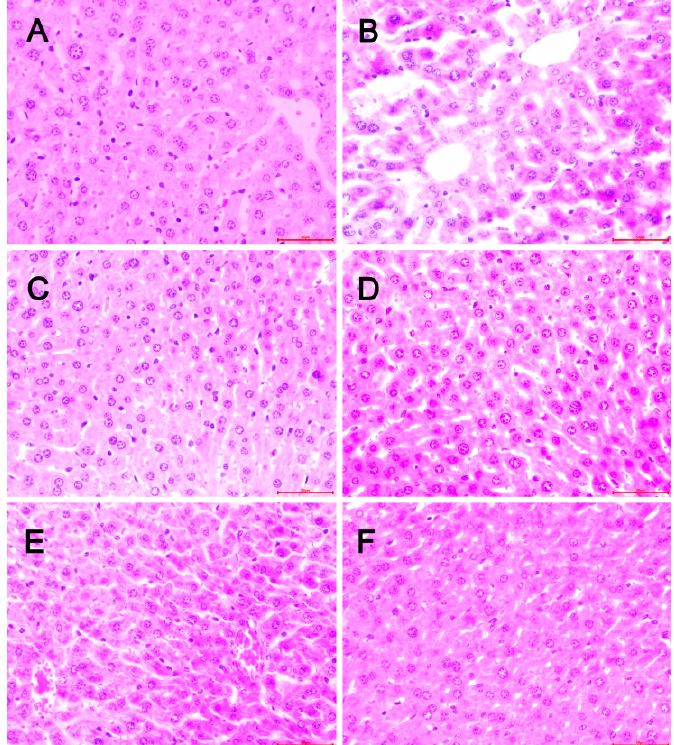
Figure 6. Effect of OP on liver histopathological changes in ALD mice. (Original magnification ×40). ( A ): Control group; ( B ): Model group (10 mL/kg bw ethanol); ( C ): Positive group (10 mg/kg bw dimethyl diphenyl bicarboxylate + 10 mL/kg bw ethanol); ( D ): OP-L group (120 mg/kg bw OP + 10 mL/kg bw ethanol); ( E ): OP-M group (240 mg/kg bw OP + 10 mL/kg bw ethanol); ( F ): OP-H group (480 mg/kg bw OP + 10 mL/kg bw ethanol).